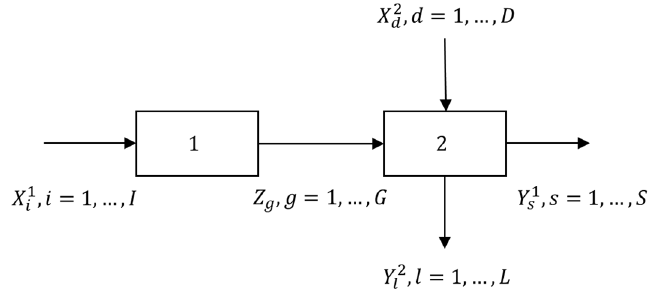
Figure 3. A two-stage system with undesirable output.